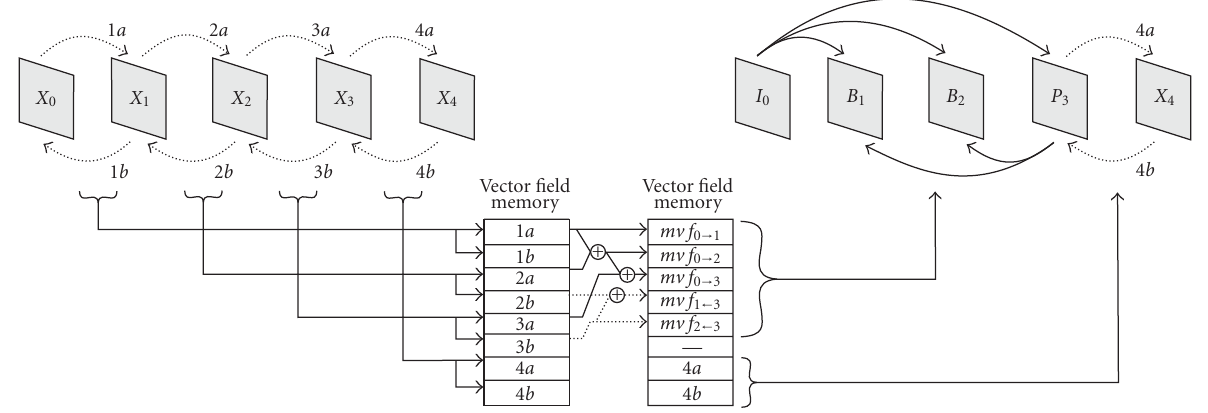
Figure 9: An overview of the new scalable ME process. Vector fields are computed for successive frames (left) and stored in memory. After defining the GOP structure, an approximation is computed (middle) for the vector fields needed for MPEG coding (right). Note that for this example it is assumed that the approximations are performed after the exemplary GOP structure is defined (which enables dynamic GOP structures), therefore the vector field (1 b ) is computed but not used afterwards. With predefined GOP structures, the computation of (1 b ) is not